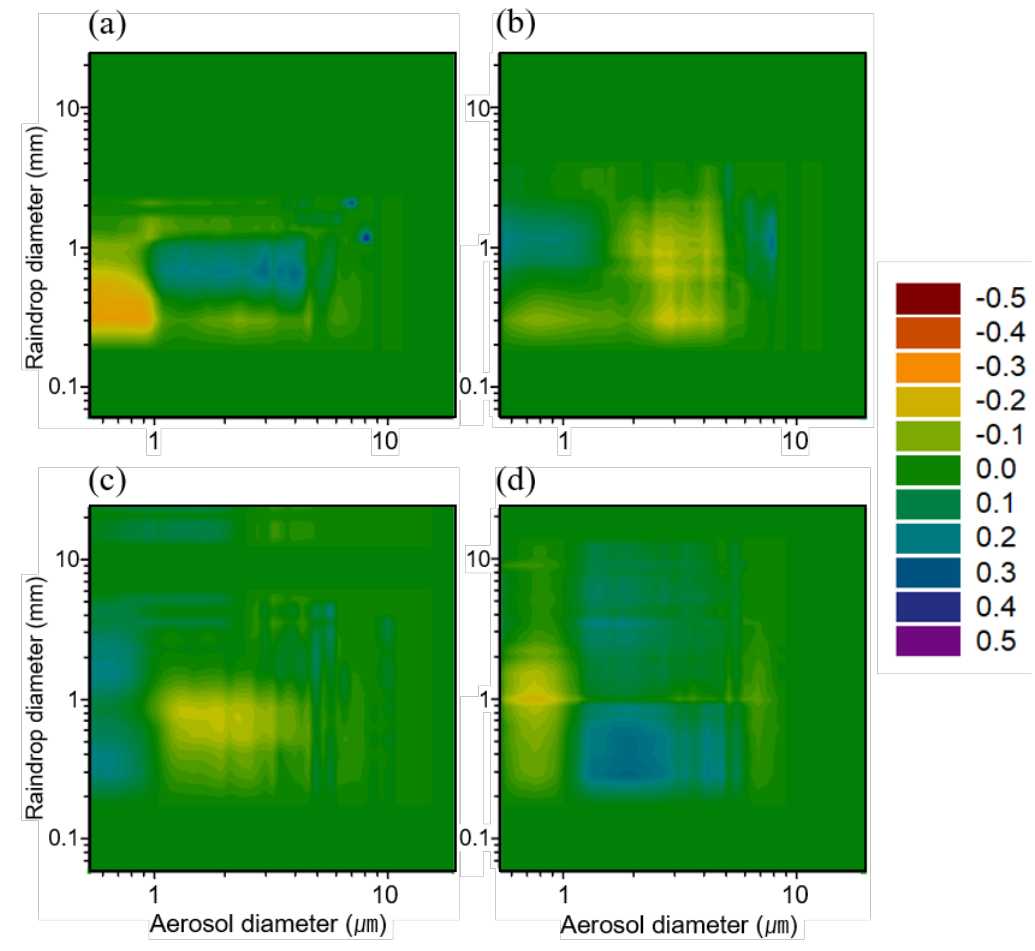
Figure 2. Distribution of correlation coefficient between aerosol and raindrop diameter from ( a – d ) (cases 1 to 4).